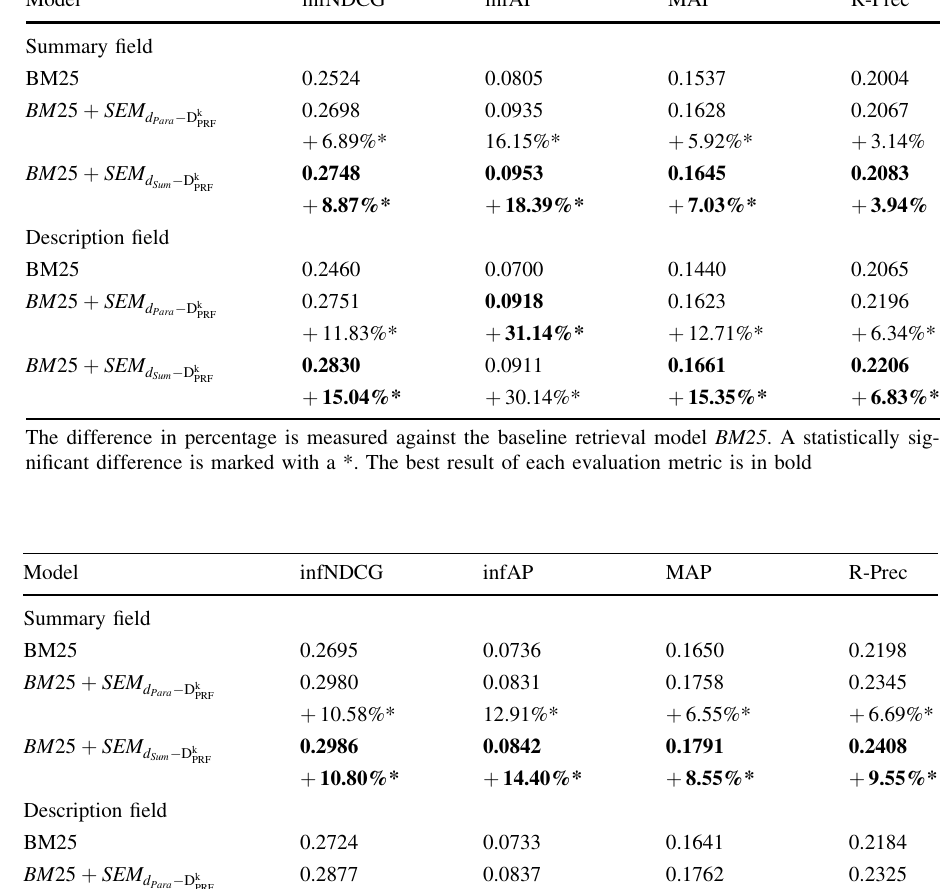
Table 2 Evaluation results on